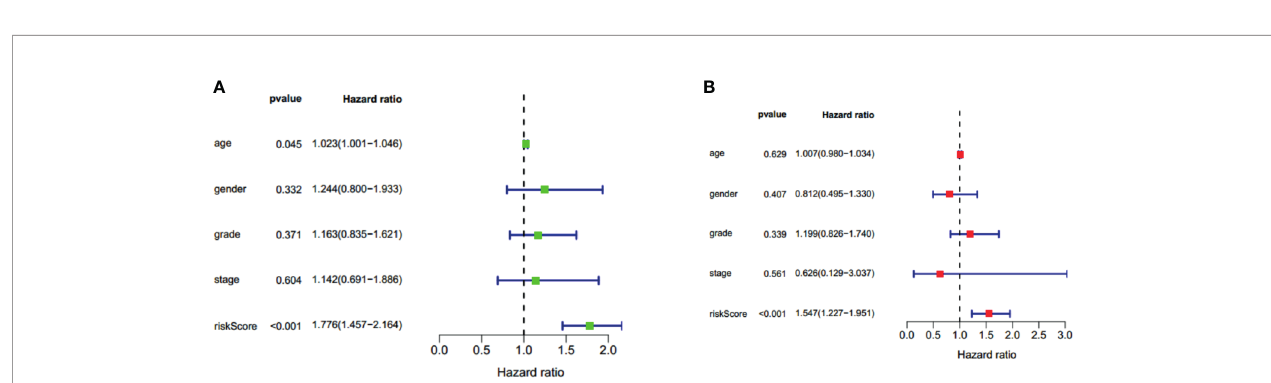
FIGURE 10 | Univariate cox regression and multivariate cox regression analysis of two gene signature in TCGA-PAAD cohort. (A) Univariate cox regression analysis of two gene signature in TCGA-PAAD cohort. (B) Multivariate cox regression analysis of two gene signature in TCGA-PAAD cohort. Factors include age, gender, grade, stage, and riskscore. Hazard ratio>1 represent a risk factor while <1 represent a protective